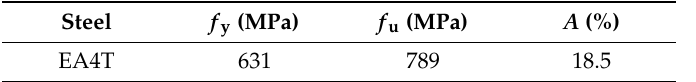
Table 2. Nominal mechanical properties of investigated steel material